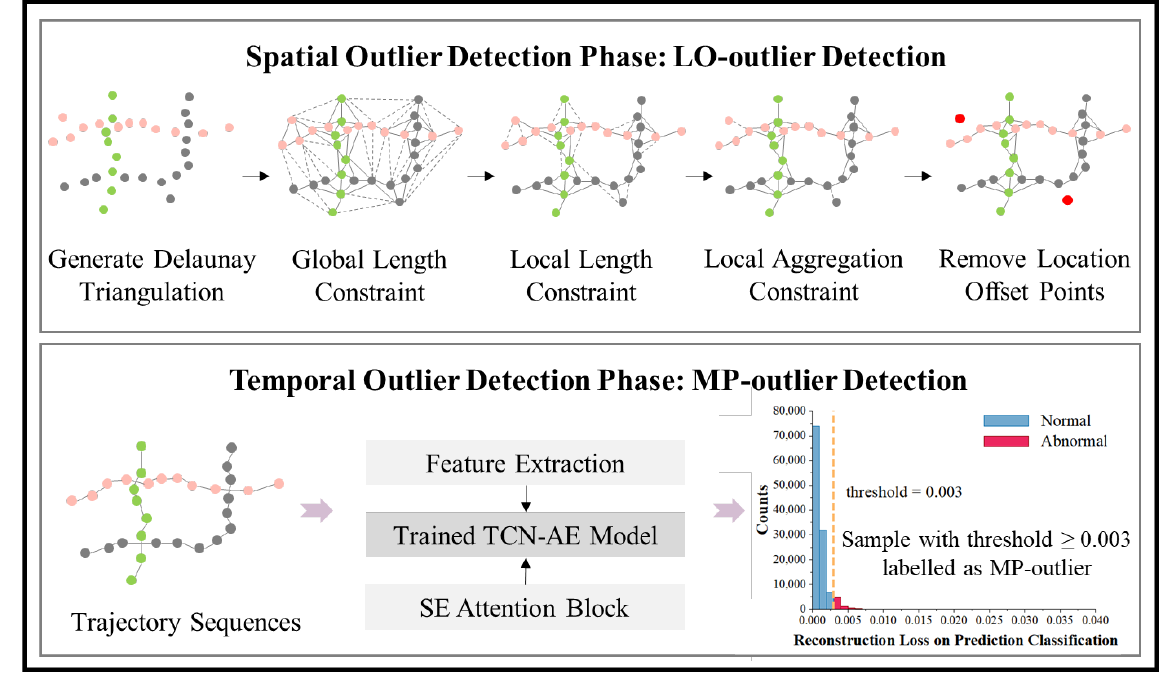
Figure 2. Framework of